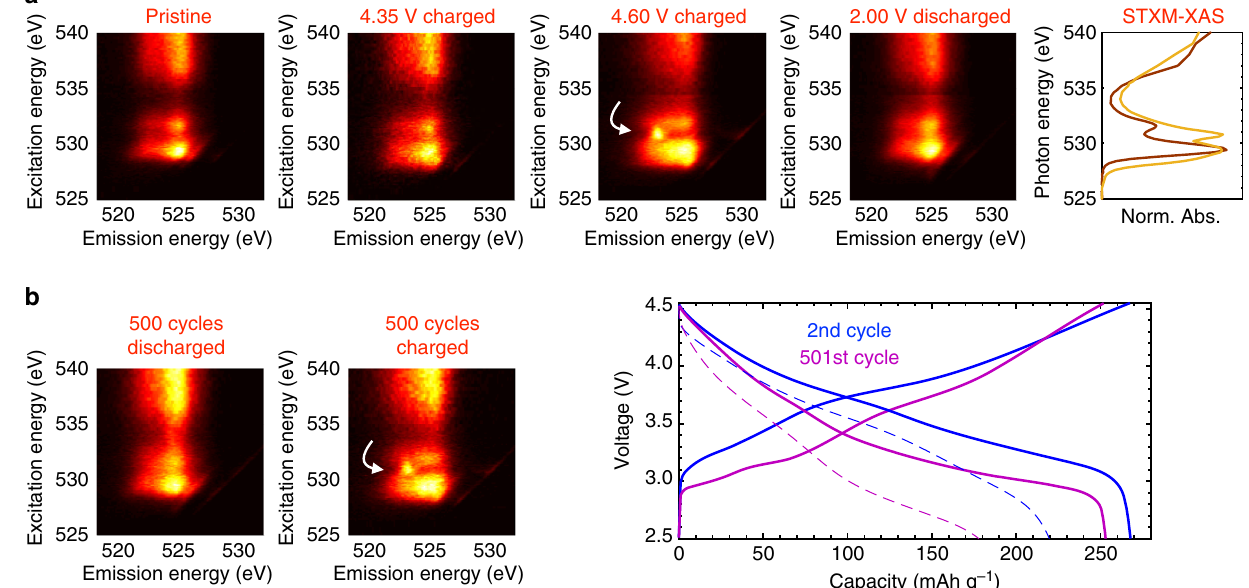
Fig. 5 Probing the nature and stability of oxygen redox. a RIXS maps at the voltages indicated throughout the fi rst cycle. The unique emission signature at 4.60V indicated by the white arrow supports an electronic restructuring associated with O redox. Right: XAS obtained in the pristine (brown) and fully charged (tan) state during the fi rst cycle for comparison. b RIXS maps acquired before and after the 501st charge on an electrode cycled 500 times at 1C/2C charge/discharge rate, showing that the reversible oxygen redox feature persists for hundreds of cycles. The voltage curves for the second and 501st cycles at C/68 (solid) and 2C (dashed) show that most of the capacity fade over 500 cycles is from increased impedance and overpotential, and that the intrinsic capacity is largely